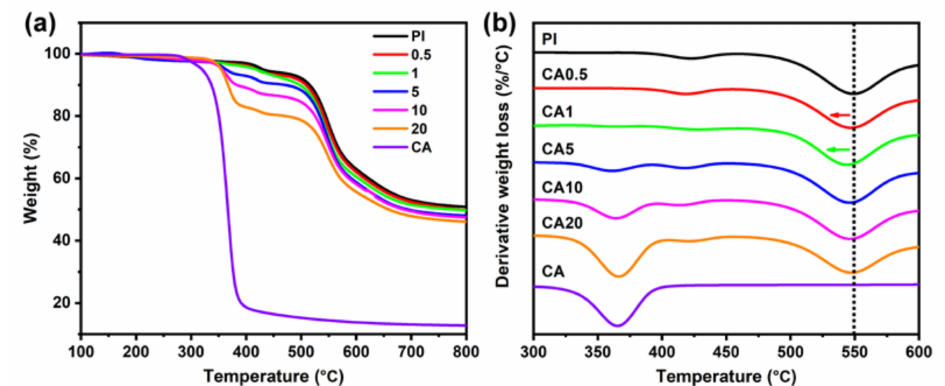
Figure 6. Thermal gravimetric analysis (TGA) of composite membranes: ( a ) weight loss curves; ( b ) derivative weight loss curves. The test is carried out at a 10